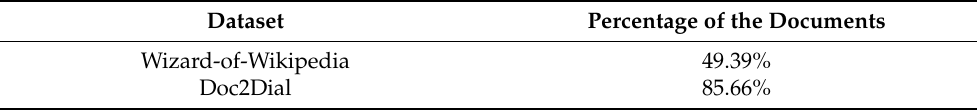
Table 3. Percentage of the truncated documents containing gold knowledge both for the Wizard-of- Wikipedia dataset and the Doc2dial dataset.